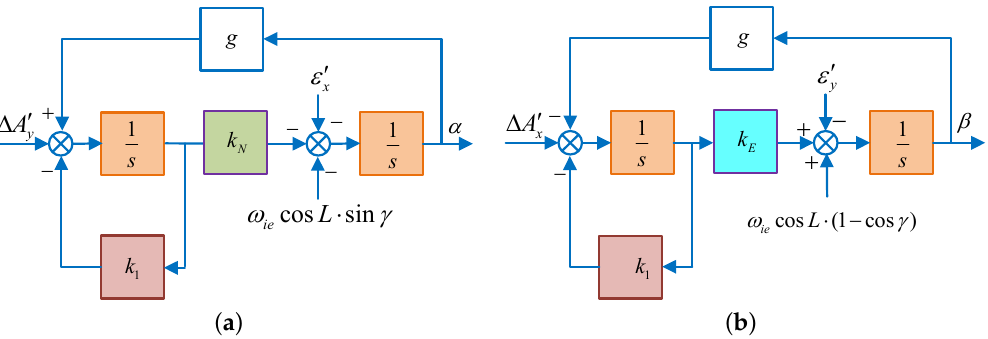
Figure 8. The schematic diagram of horizontal fine alignment in System 1. ( a ) Schematic diagram of horizontal fine alignment in the north loop; ( b ) schematic diagram of horizontal fine alignment in the east loop.